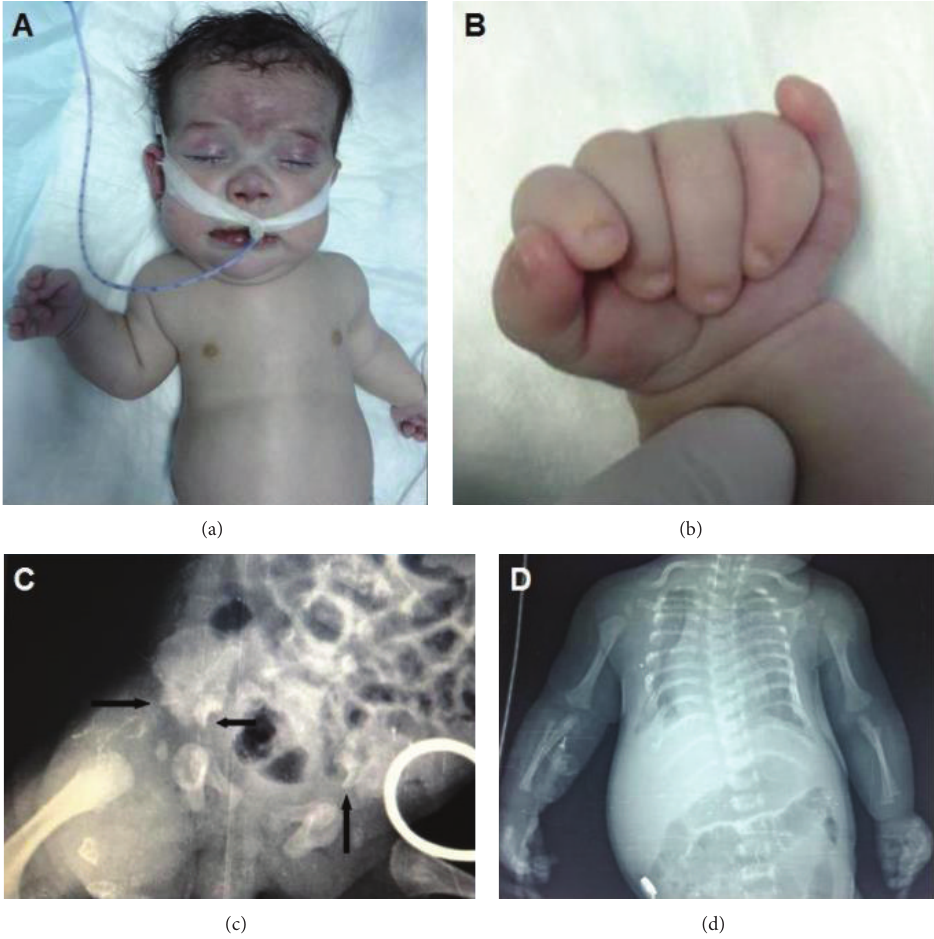
Figure 1: Clinical and X-ray features of the baby: (a) characteristic facial features of prominent forehead, low-set ears, narrow thorax, short upper extremities, a short and flat nose, and micrognathia; (b) polydactyly and hypoplastic nails of the hands; (c) trident aspect of the acetabular roof, ossification defects at the inferior aspect of the lateral iliac margin; (d) narrow thorax, short ribs, and high clavicle